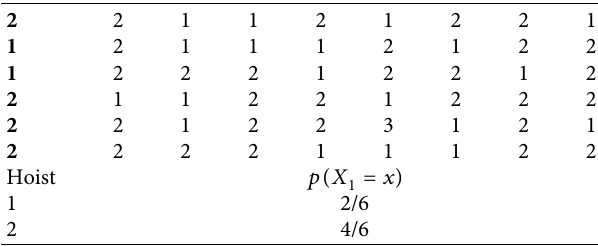
Table 7: Selected hoist assignment